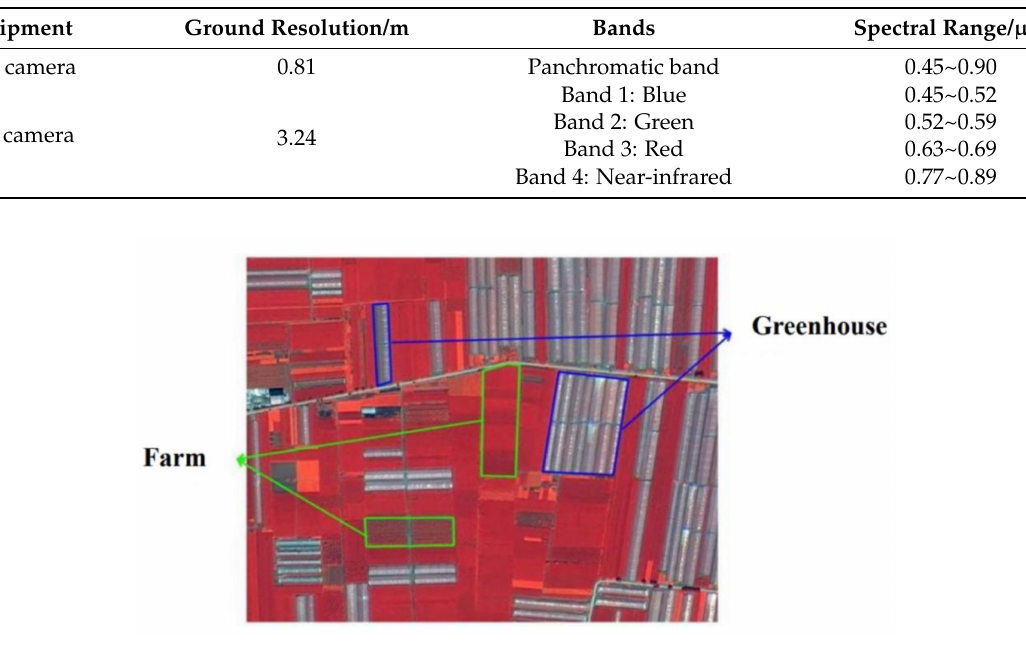
Table 1. Spectral information of GF-2 camera.